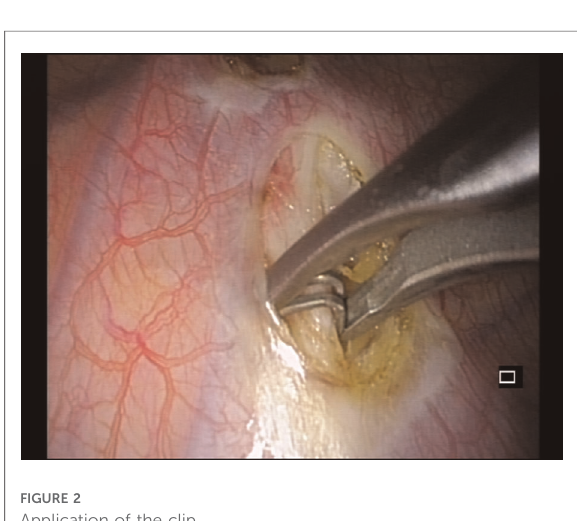
FIGURE 2 Application of the clip.